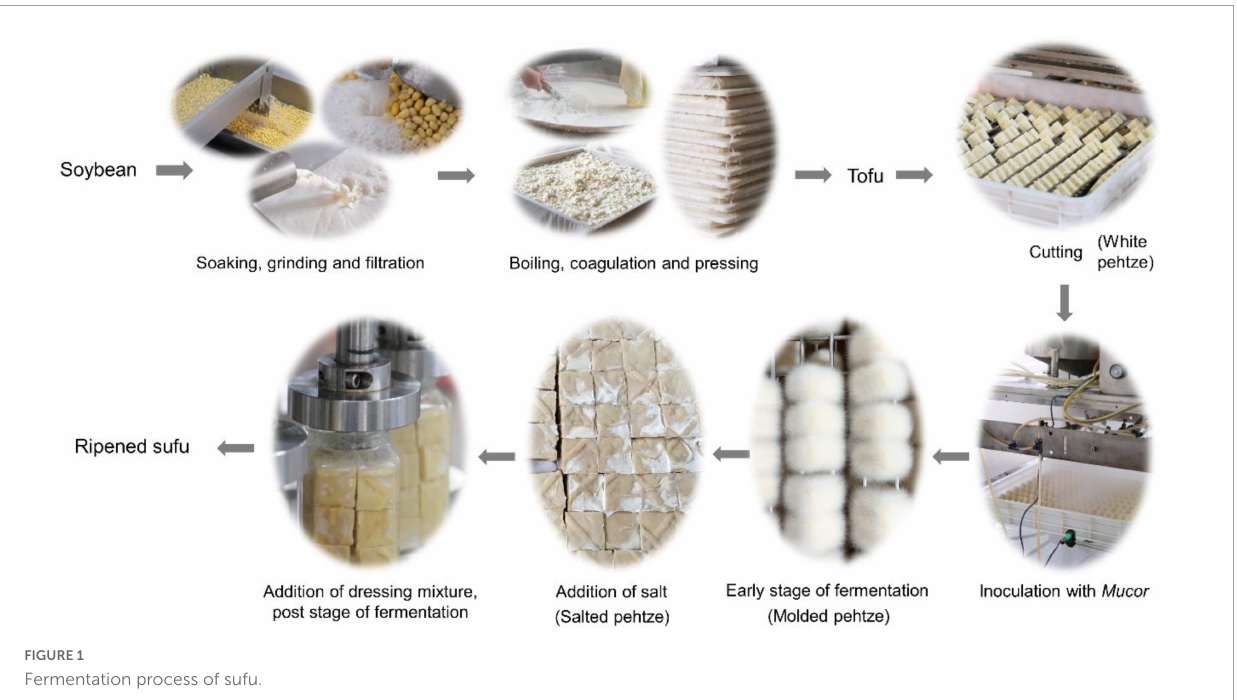
FIGURE1 Fermentation process of